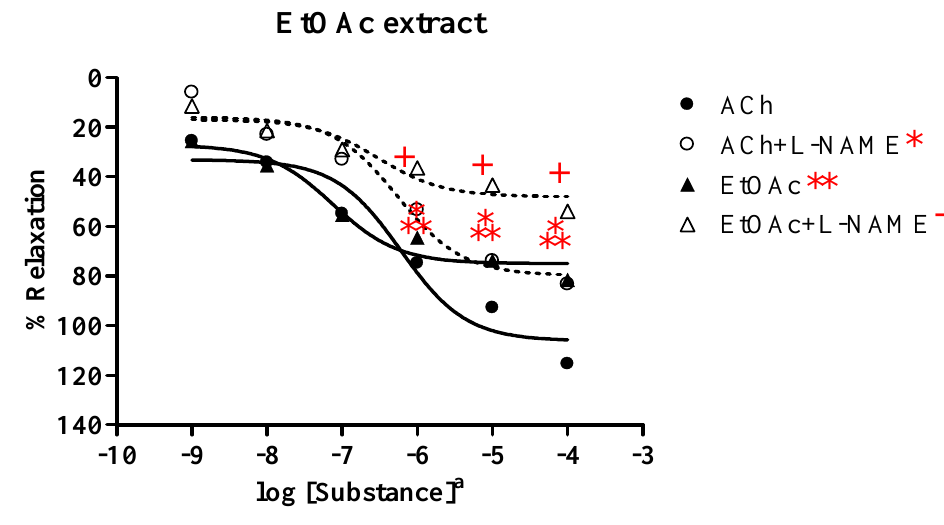
Figure 4. Effect of EtOAc extract and ACh on the vascular function of rat thoracic aorta in the absence or presence of 1 mM L -NAME.